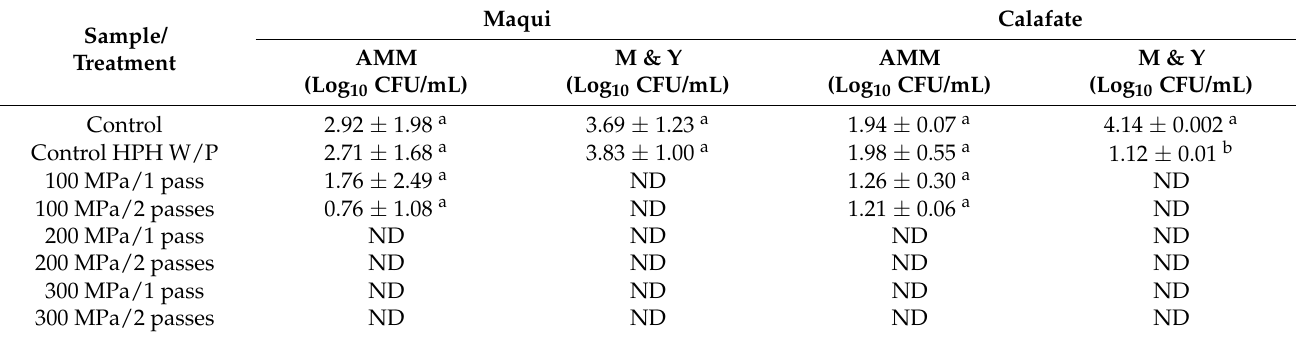
Table 1. Counts of aerobic mesophilic microorganism (AMM) and mold and yeast (M & Y) in maqui and calafate extracts subjected to high-pressure homogenization (HPH) and